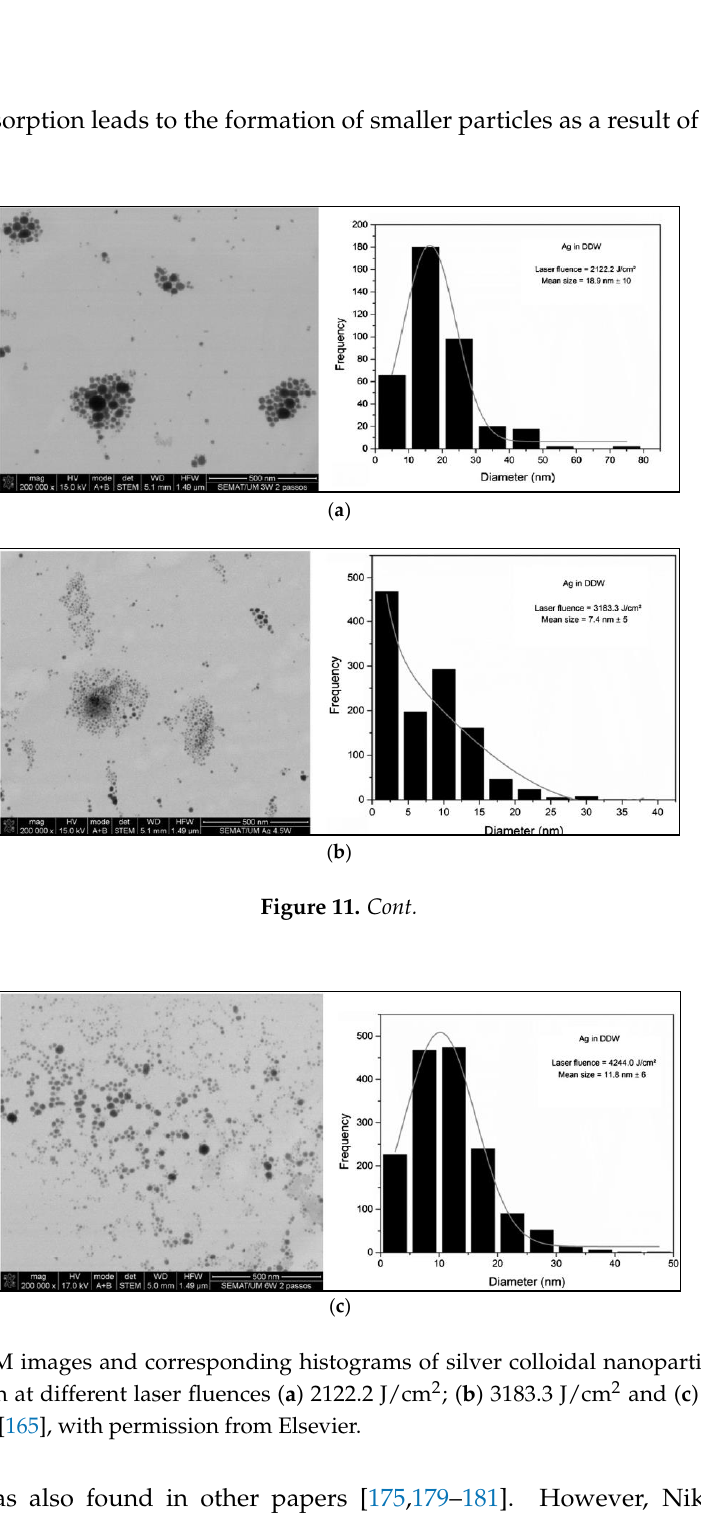
Figure 10. Ablated mass versus laser pulse fluency. Reprinted from [179], an open access article